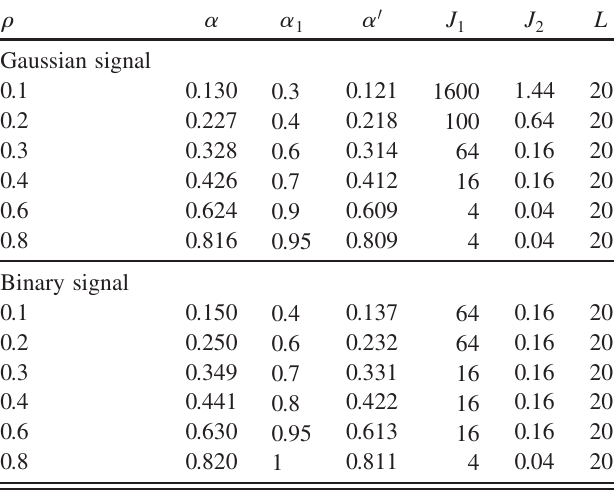
TABLE I. Parameters used for the s-BP reconstruction of the Gaussian signal and the binary signal in Fig.